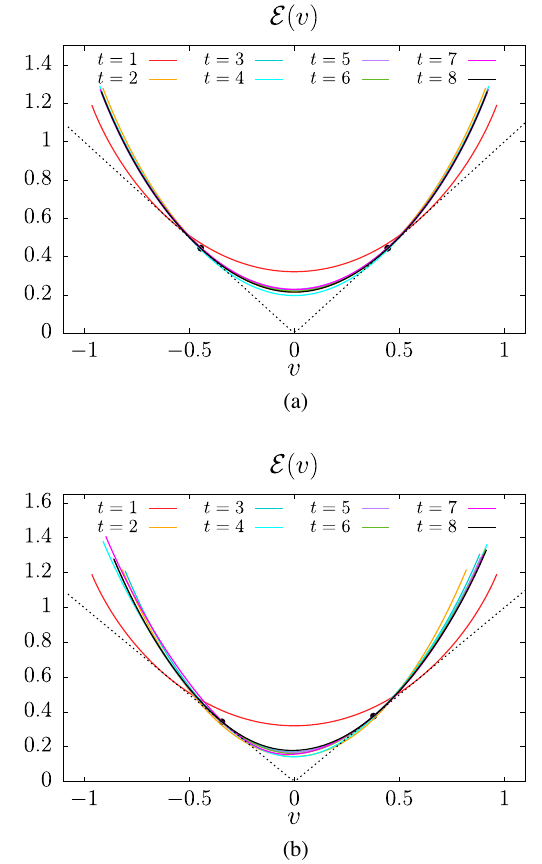
FIG. 7. Numerical computation of E ð v Þ with t up to 8 for max (a) the reflection-symmetric gate in Eq. (72) with x ¼ 0 . 8 ; (b) a generic nonsymmetric gate (specified in Appendix B). Black dots from an independent calculation of the mark estimates of v L=R B OTOC in Appendix B